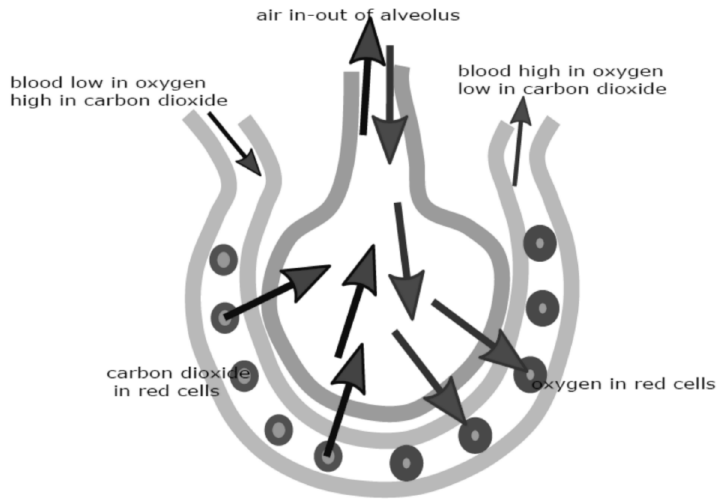
Figure 6. Diffusion of oxygen and carbon dioxide in the